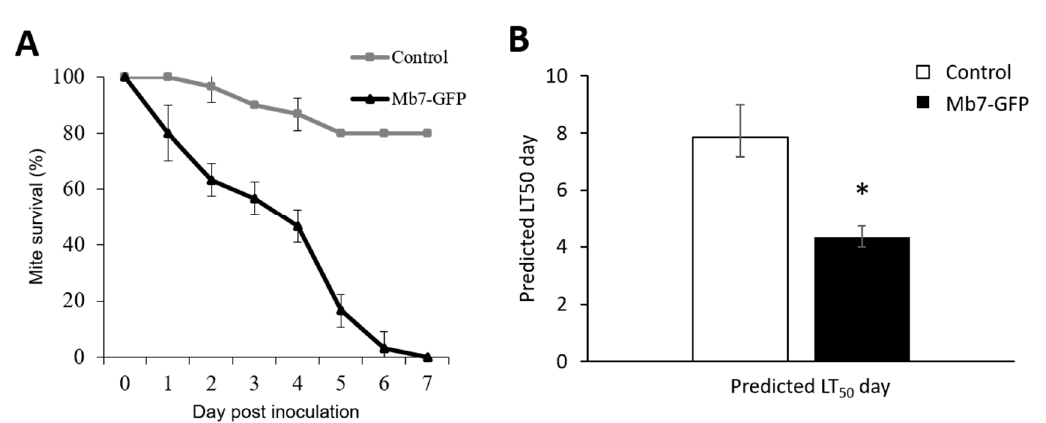
Figure 6. Assessment of Mb7 effect on survival of Rhizoglyphus robini in vitro . ( A ) Survival of adult R. robini after direct exposure to Mb7 conidia (10 7 conidia mL − 1 ). ( B ) LT 50 analysis of Mb7 against R. robini adult mites (DF = 3, χ 2 = 322.5, p < 0.0001). *Significantly different at p < 0.05.